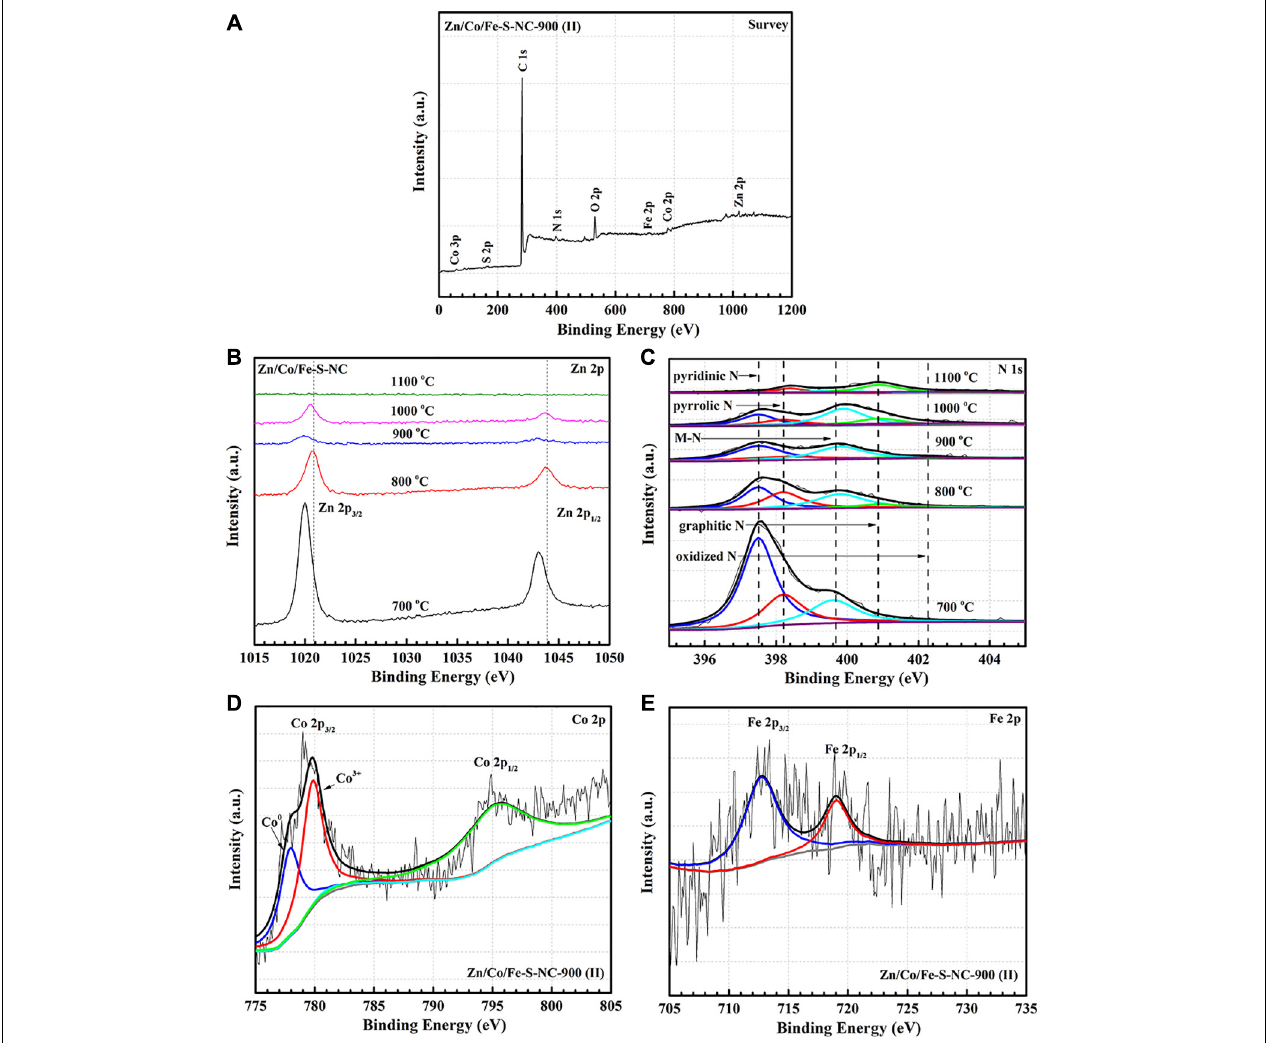
FIGURE 5 | X-ray photoelectron spectroscopy spectra of the Zn/Co/Fe–S–NC and control samples. (A) XPS survey scan of Zn/Co/Fe–S–NC-900, (B) Zn 2p XPS spectra of Zn/Co/Fe–S–NC with different temperatures (700–1,100 ◦ C), (C) N 1s XPS spectra of Zn/Co/Fe–S–NC with different temperatures (700–1,100 ◦ C), (D,E) detailed Co 2p and Fe 2p XPS spectra of